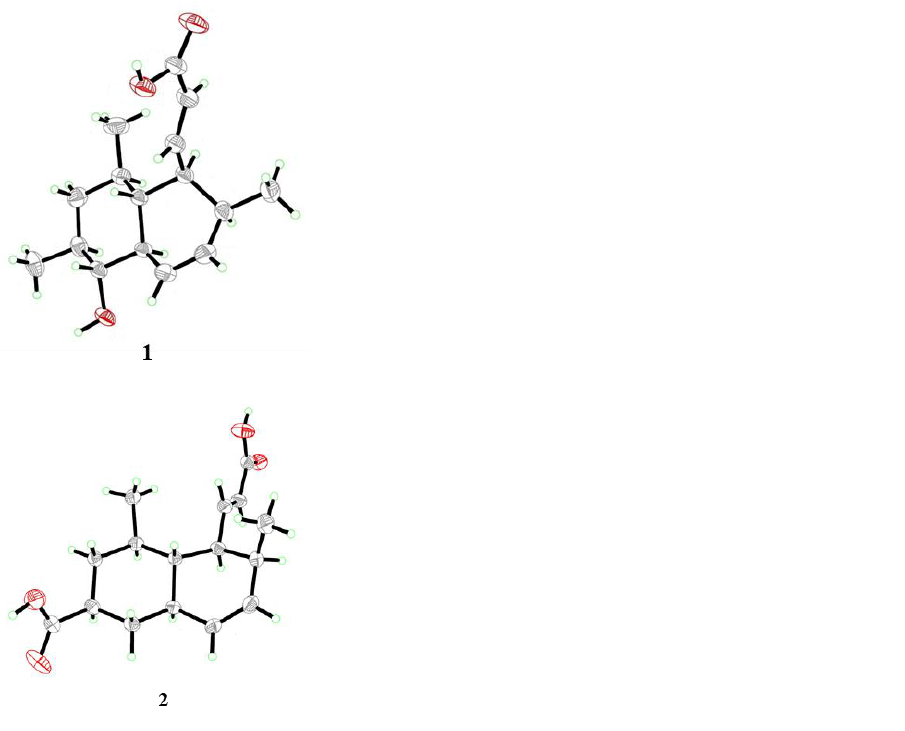
Figure 4. X-ray crystallographic structures of compounds 1 and 2 (with a thermal ellipsoid proba- bility of 50%). of